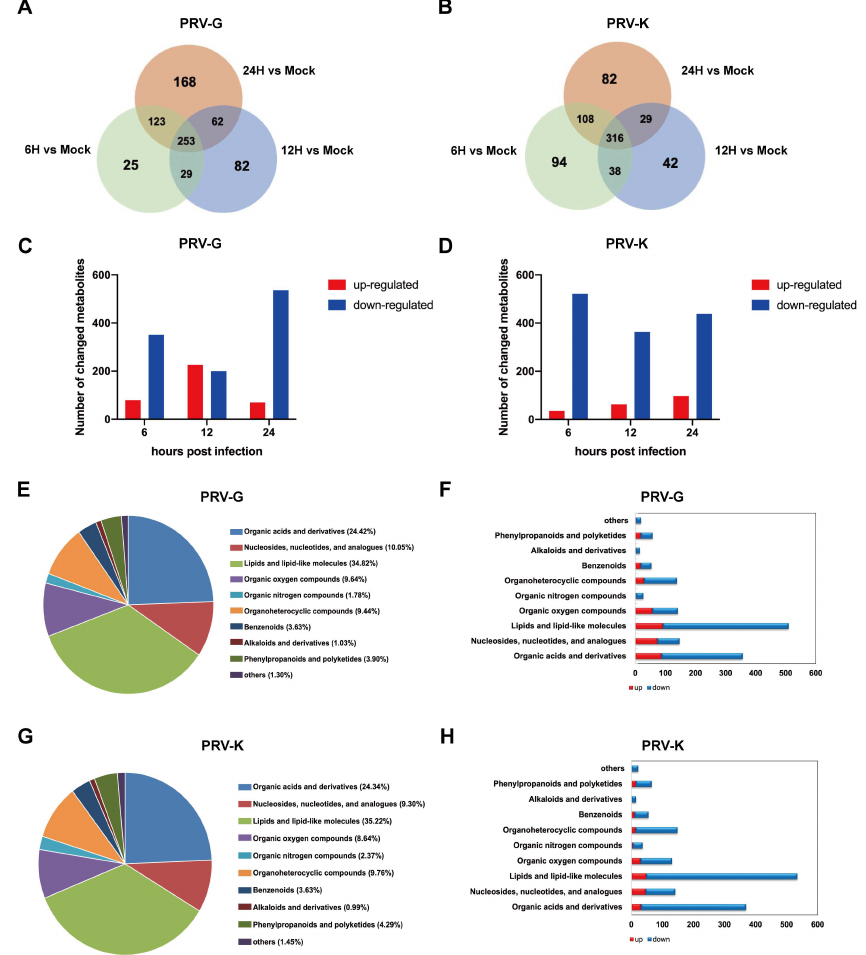
Figure 3. Analysis of differentially expressed metabolites in PK-15 cells infected with different PRV strains. ( A , B ) Venn diagrams between PRV-infected groups (6H, 12H, 24H) and mock group. ( C , D ) Numbers of differentially expressed metabolites upregulated (red) and downregulated (blue) in infected groups. ( E – H ) Pie charts and the histogram graphs showing proportions of different categories among differentially expressed metabolites in PRV-infected PK-15